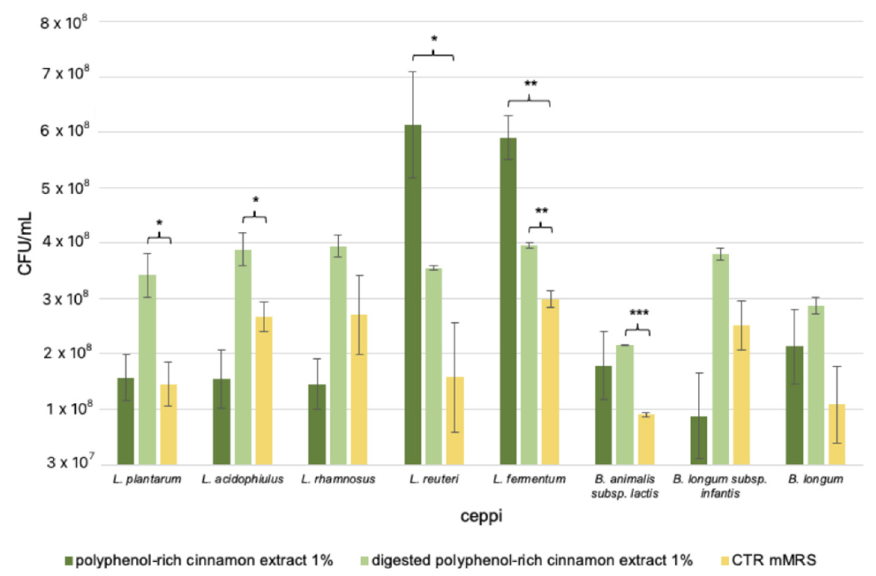
Figure 4. Analysis of the probiotic potential of polyphenol-rich and digested cinnamon bark extract on Lactobacillus and Bifidobacterium strains. Growth levels of the selected probiotic strains in the presence of polyphenol-rich cinnamon bark extract, digested polyphenol-rich cinnamon bark extract, and CTR medium at 1% concentration. Values are represented as mean values of CFU/mL ± SE. Statistical differences were calculated using t -Student’s test: * p -value < 0.1, ** < 0.05, and *** < 0.01.